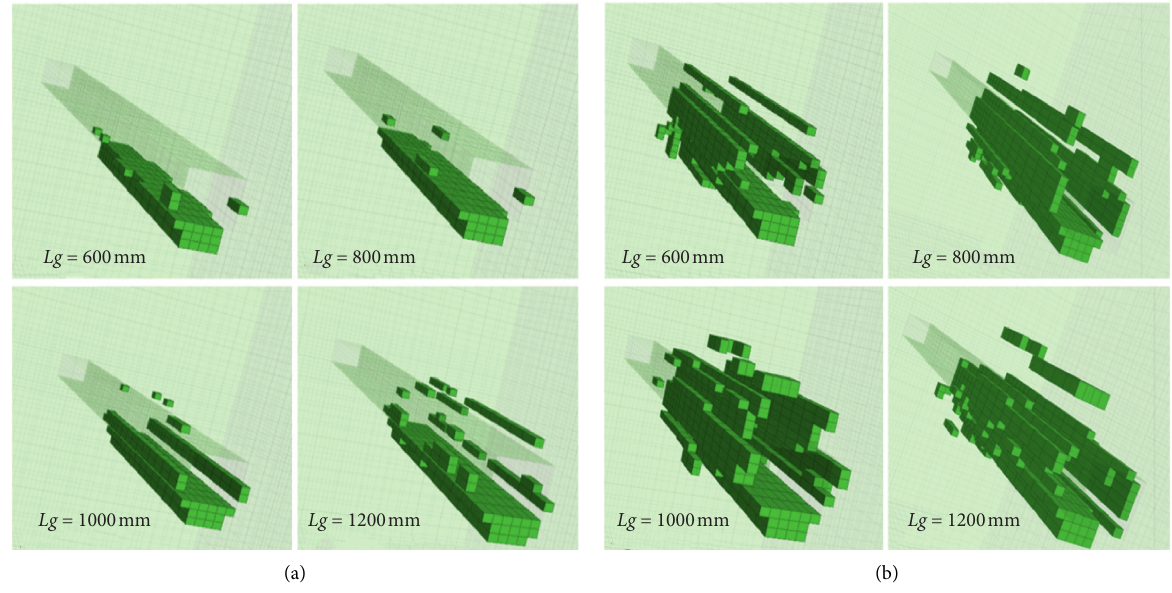
Figure 8: Roadway tensile failure distribution with different rock bolt spacings: (a) T � 0 s; (b) T � 0.1s. Table 11: Number of tensile failures with different bolt spacings.